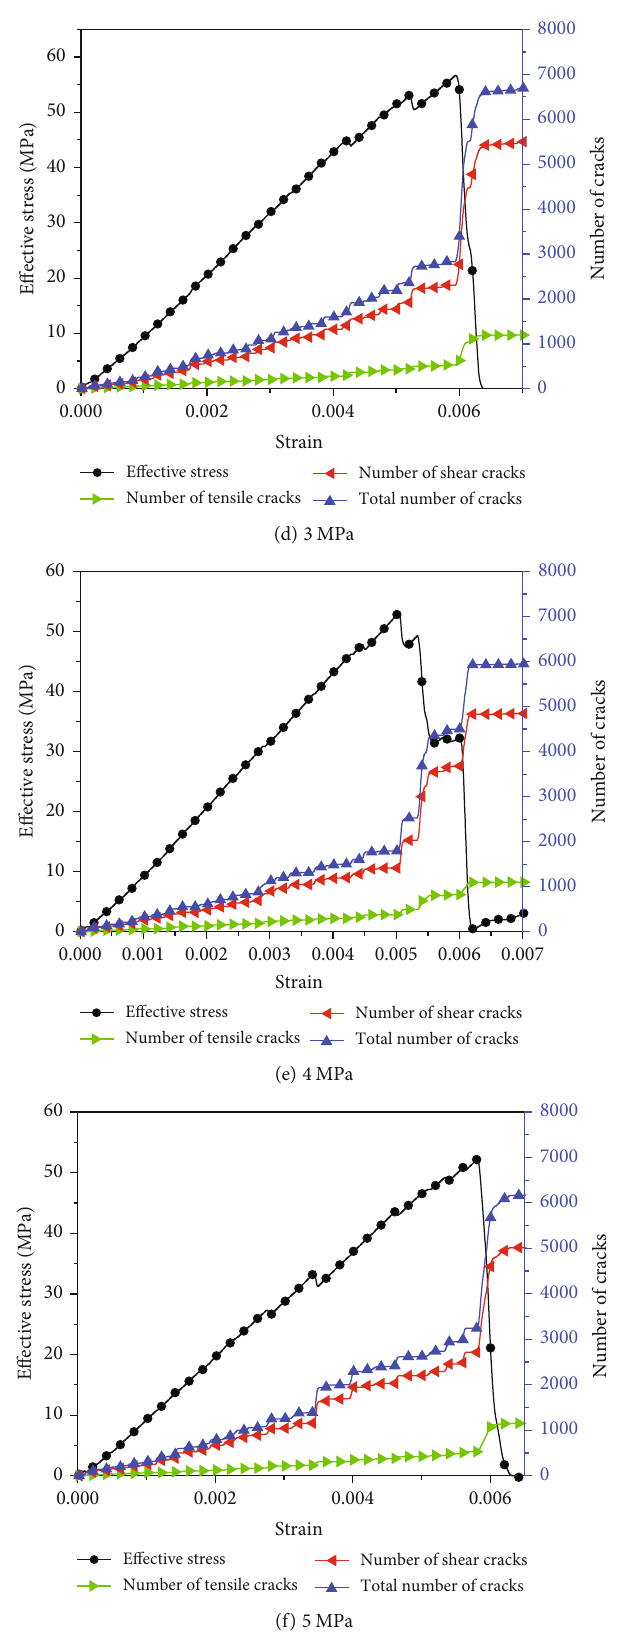
Figure 11: Changes of the number of cracks in gas-containing coal during deformation and